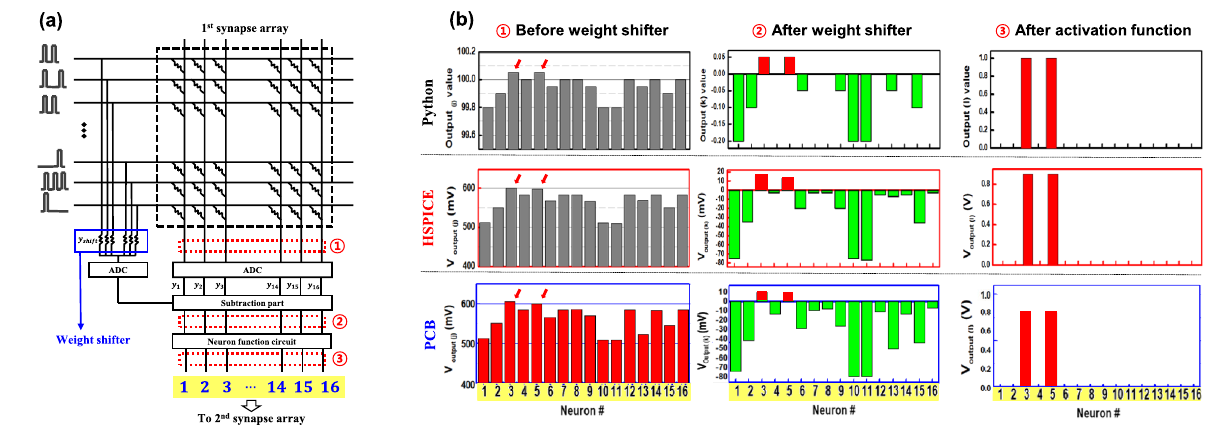
Figure 5. ( a ) Simplified schematic of realized H-DNN. To demonstrate the weight shifter, various output results (at 1 before weight shifter, 2 after weight shifter, and 3 after activation function) are compared by the S-DNN (Python), circuit simulator (HSPICE), and H-DNN (PCB). ( b ) The obtained output results were the same for all three cases: Python, HSPICE, and shown in Fig. 4b (Figs. S2–S4). The higher number of input node showed higher recognition accuracy. However, for hardware implementation, minimum number of input node which can exhibit more than 90% accuracy was selected (Fig. 4a). There were also various dependence of input data type, resampling size, and quantization bit on the accuracy, as shown in Figs. S2–S4. To effectively minimize the hardware resources, we considered all above parameters (number of input node, input data type, resampling size, and quantization bit). Based on the optimized condition of Fig. 4, the weight shifter was evaluated and compared in three respects: S-DNN, circuit simulator, and PCB circuit (Figs. 5 and S5). The hardware implemented circuit having weight shifter is composed of input layer, 1st synapse arrays (16 × 16), weight shifter, neuron parts (analog to digital circuit (ADC), subtraction part, and activation function), 2nd synapse array (16 × 2), and output layer, as shown in Figs. 5a and S5.